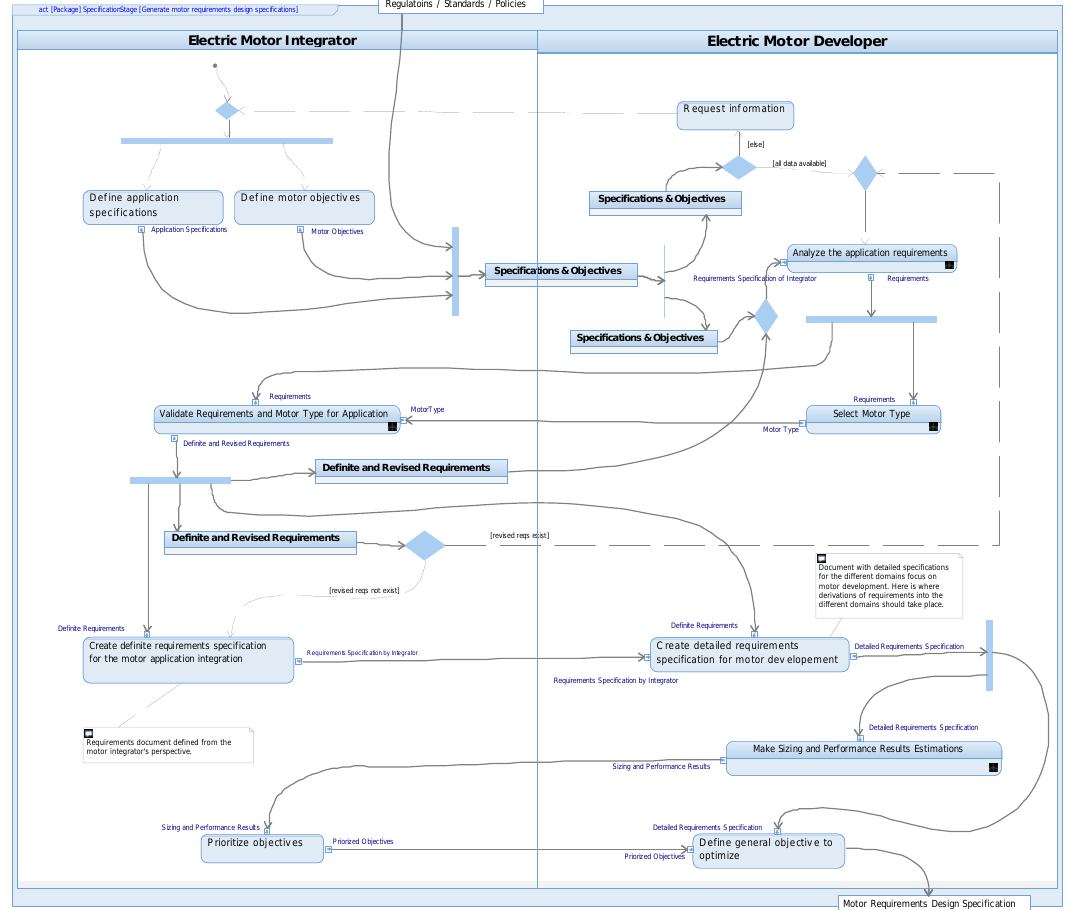
Figure 4. Main activity diagram of the framework.